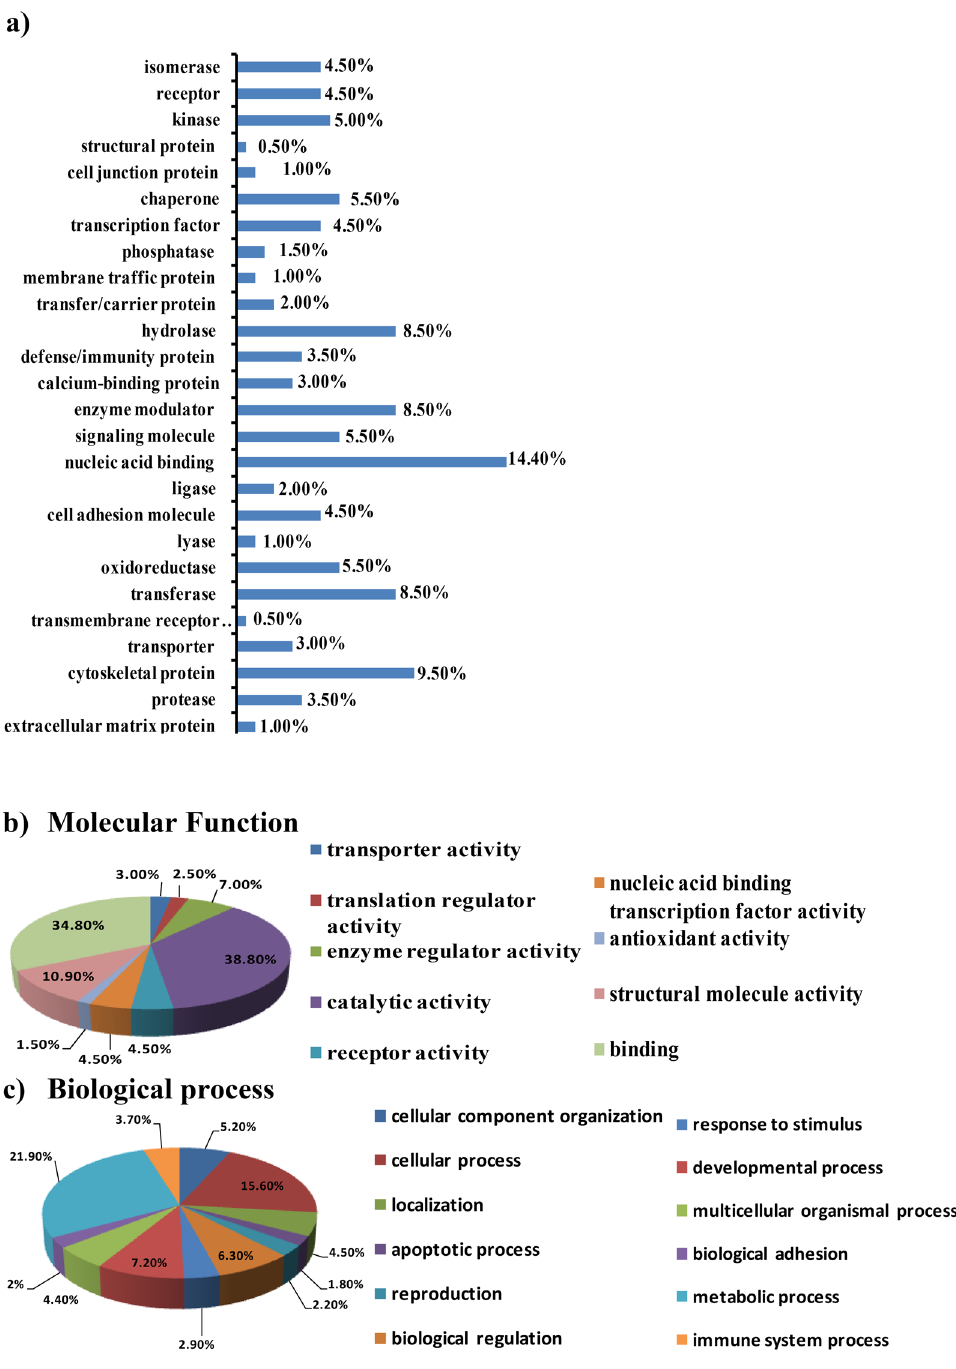
Figure 2 . Gene ontology analysis of up and down-regulated proteins. ( a ) Protein functional classification presenting 225 proteins classified in 26 categories. ( b ) Molecular function. 70% MEM treatment-induced proteins. ( c ) Biological process. MEM regulated proteins were found to be involved in 16 biological processes. Gene ontology analysis was performed in the PANTHER database (http;//www. panth erdb.